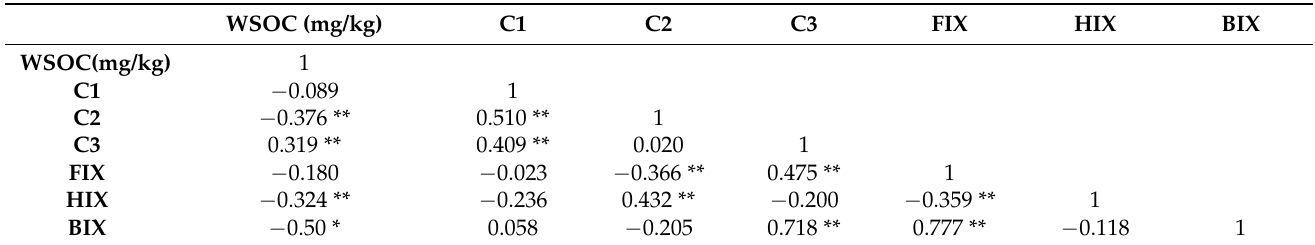
Table 6. Correlations (r) among WSOC parameters in the five treatment groups (CK, NPK, BC, NPK + BC, and N +